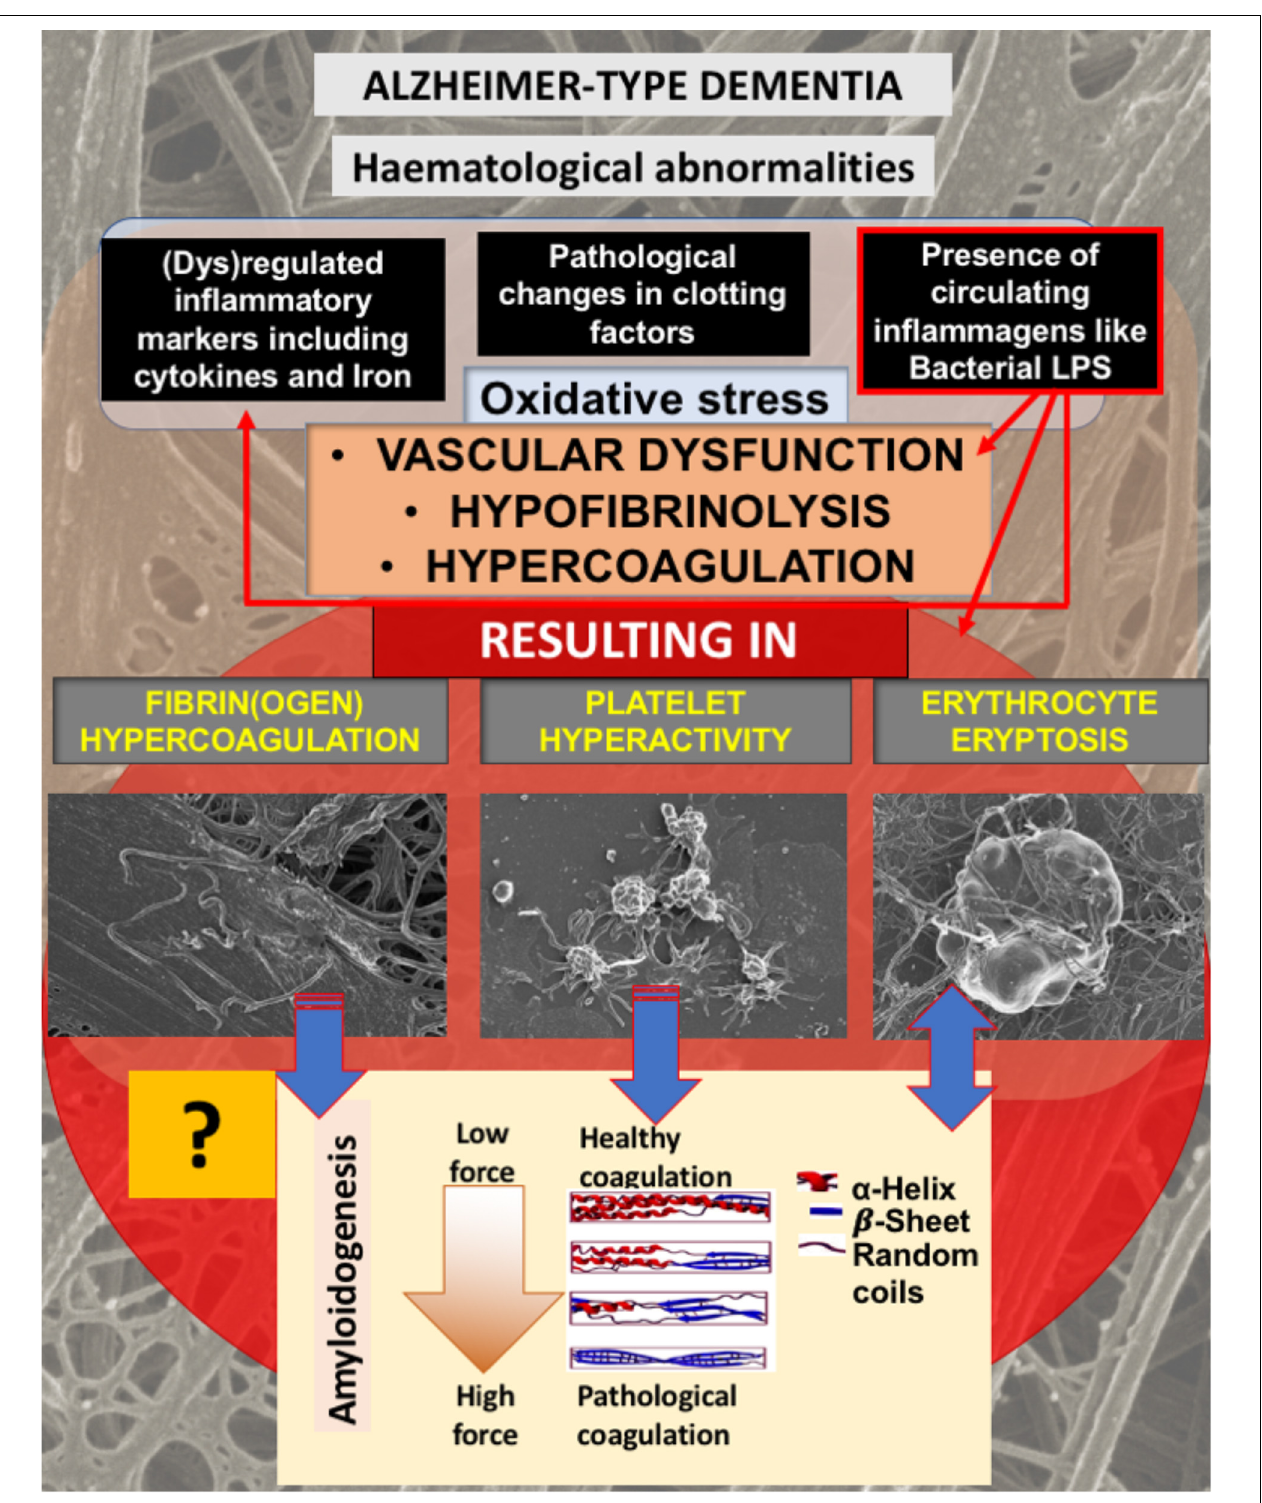
FIGURE 1 | Alzheimer-type dementia (AD) is associated with hematological abnormalities that include (dys)regulated cytokines, iron and clotting factors. Increased LPS levels are also known to be present in AD. We have suggested that the presence of LPS not only is one of the causes of (dys)regulated cytokines, clotting factors and oxidative stress, but the cause of fibrin(ogen) and RBC dysfunction. We investigate here if fibrin(ogen) in AD is amyloid in nature, and if LBP can reverse fibrin(ogen) amyloid structure.